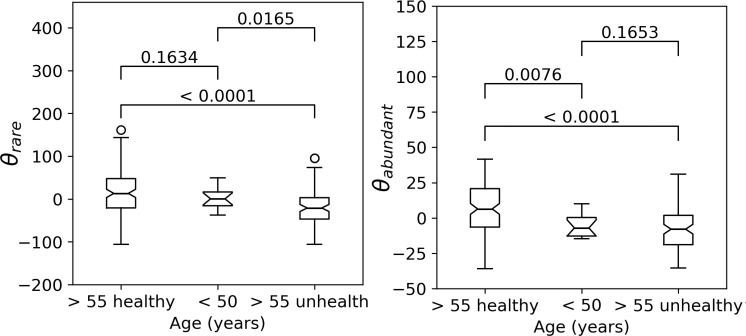
GM biodiversity and healthy aging status.Box-plots representing the distribution of GM biodiversity (θrare on the left and θabundant on the right) in the healthy elderly, young controls and unhealthy elderly subjects from the ELDERMET data set at T0. Mann-Whitney U-test p-values are reported for each pairwise comparison. Both biodiversity indices were adjusted for sex and total number of reads before computing the box-plots and hypothesis tests.